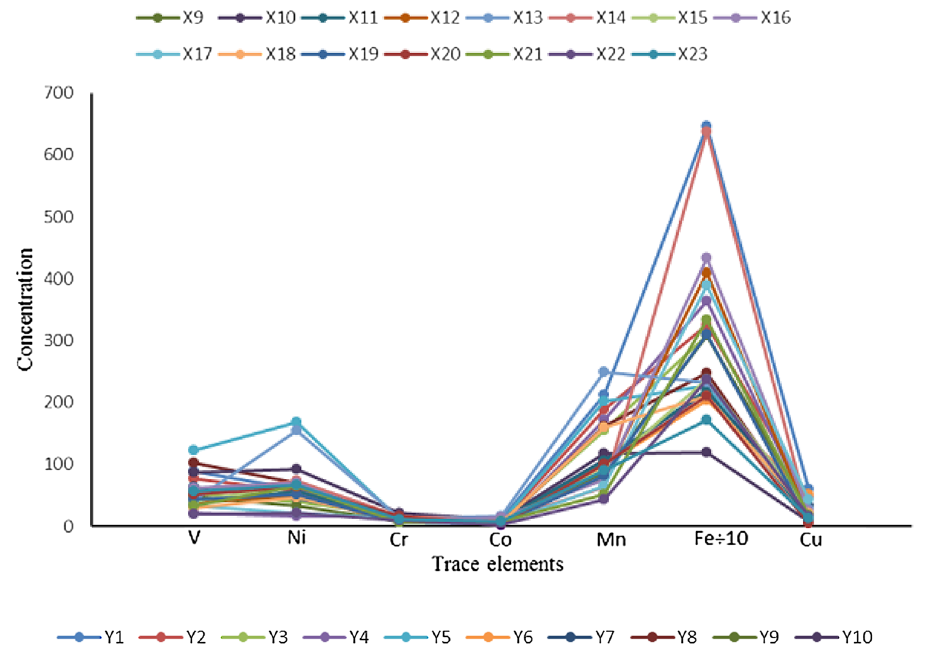
Fig. 5 Trace elements distribu- tion patterns of kerogens from Well